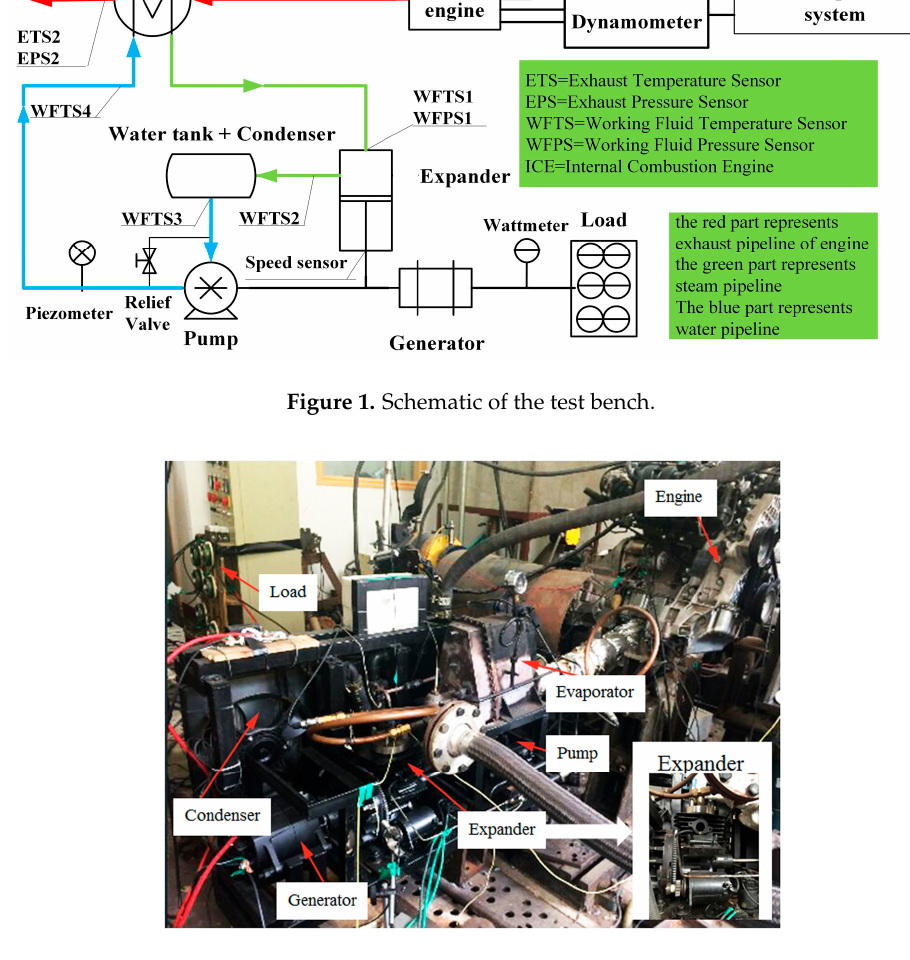
Table 1. Parameters for the main instruments of test system.